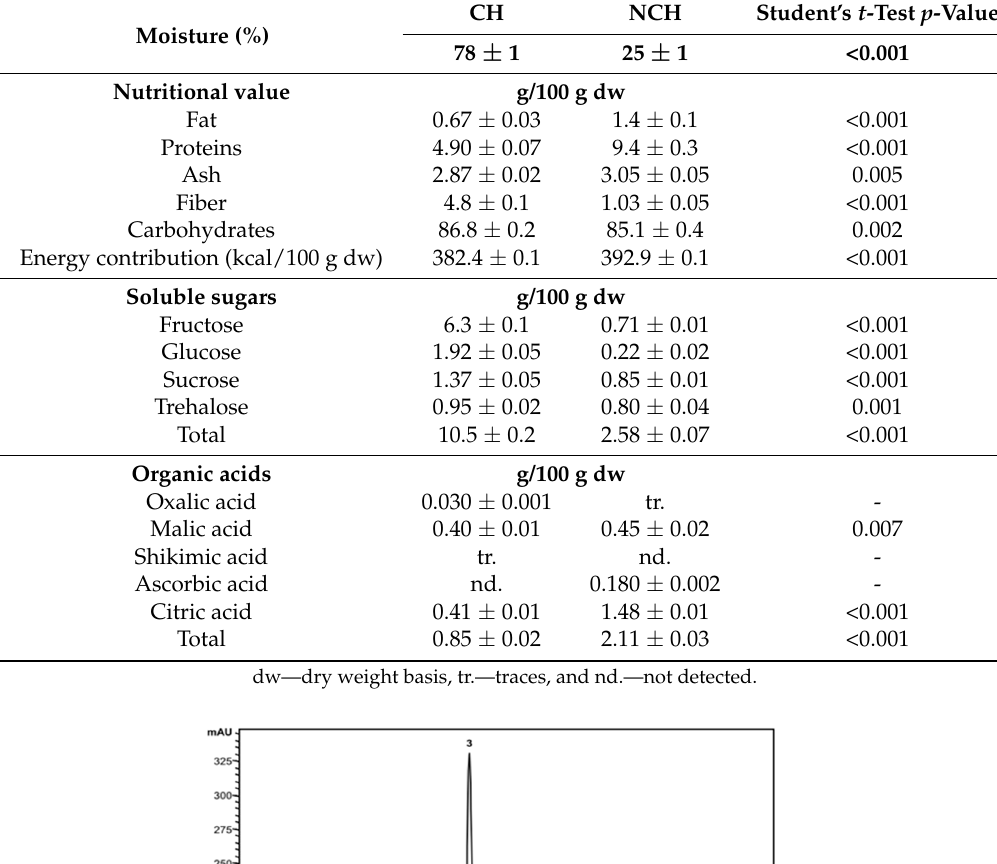
Table 1. The nutritional value, soluble sugars, and organic acids composition of Cytinus hypocistis subsp. macranthus Wettst. (L.) L. using the whole plant (CH) and its nectar (NCH). Mean ± SD.